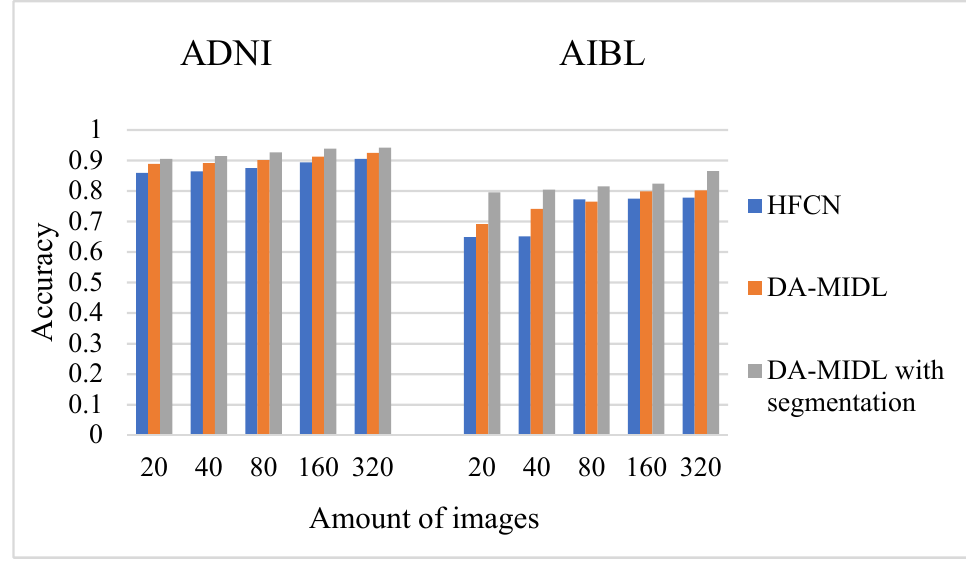
Figure 4. Accuracy comparison outcomes between DA-MIDL, HFCN, and the proposed DA-MIDL Figure 5. Sensitivity comparison outcomes between DA-MIDL, HFCN, and proposed DA-MIDL with segmentation. with segmentation.